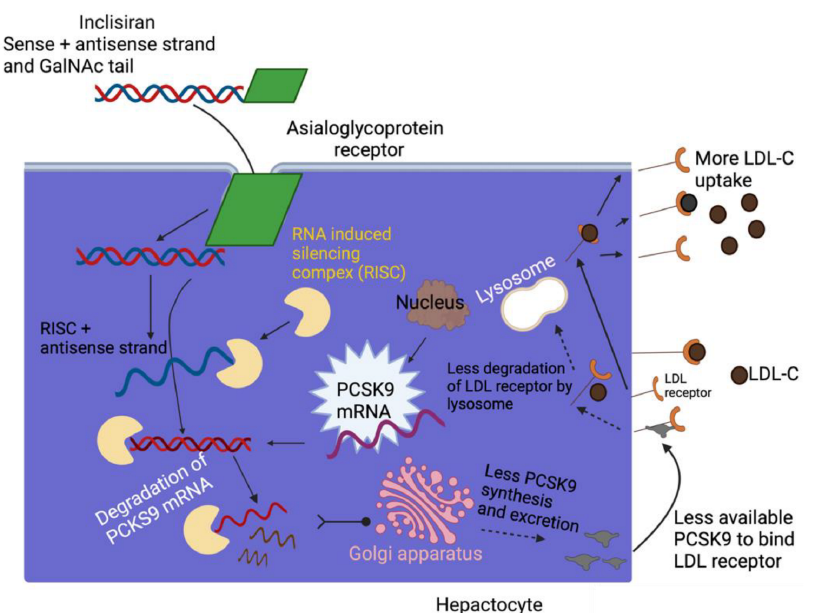
Figure 7. Schematic of the mechanism of action of inclisiran. Figure created with BioRen- der.com (accessed on September 29, 2022). Adapted from Cupido AJ, Kastelein JJP. Cardiovasc Res . 2020;116(11):e136-e139. GalNAc—N-acetylgalactosamine; LDL—low-density lipoprotein; LDL- C—LDL cholesterol; LDL-R—LDL receptor; PCSK9—proprotein convertase subtilisin/kexin type 9; RISC, RNA—induced silencing complex; siRNA—small interfering